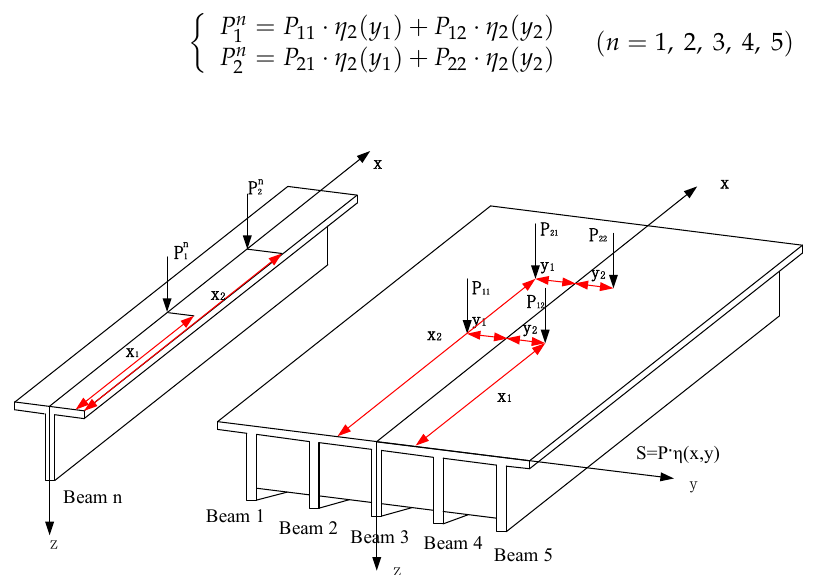
Figure 4. Wheel load transverse distribution on the bridge. Assuming that the above vehicle loads drive parallel to the x coordinate from one end to the other end of the beam, the measured strain integral values of the mid-span Scheme 1 are A 2 , A 3 , A 4 and A 5 , respectively. In addition, it is assumed that the mid-span strain integral coefficients of each beam bottom are α 1 , α 2 , α 3 , α 4, and α 5 , respectively. The